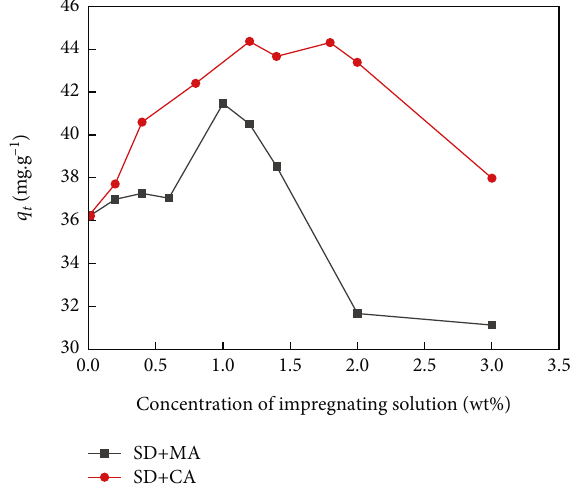
Figure 4: The e ff ect of concentration of impregnating solution on boron adsorption capacity on SD +MA and SD+